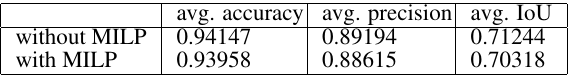
Table 3. Detection results of Faster R-CNN without and with MILP